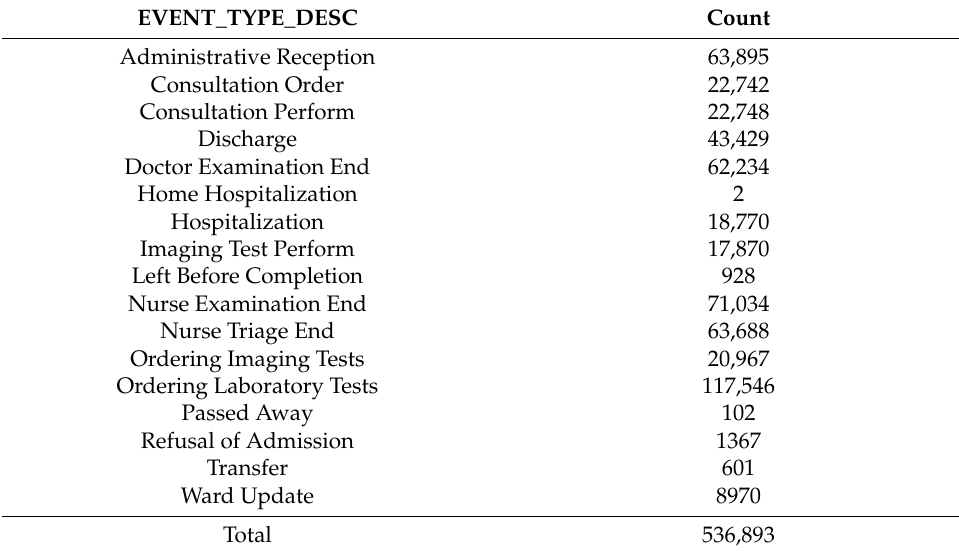
Table 1. Event type